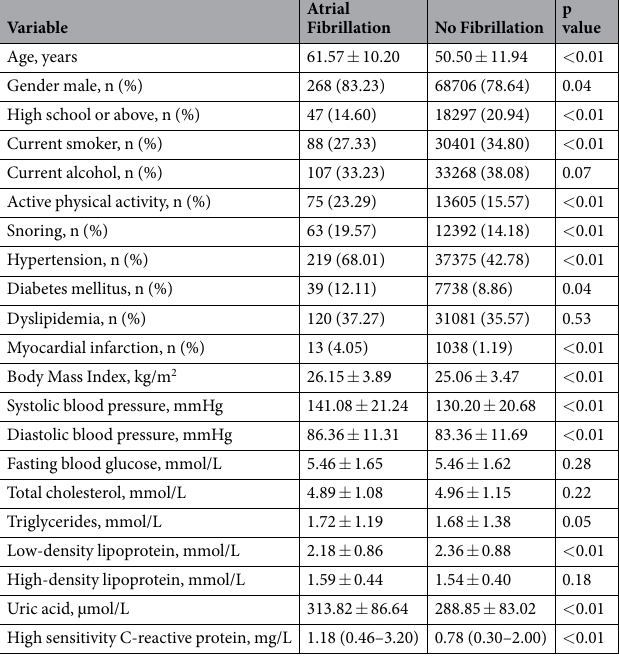
Table 2. Differences in baseline characteristics between patients with and without atrial